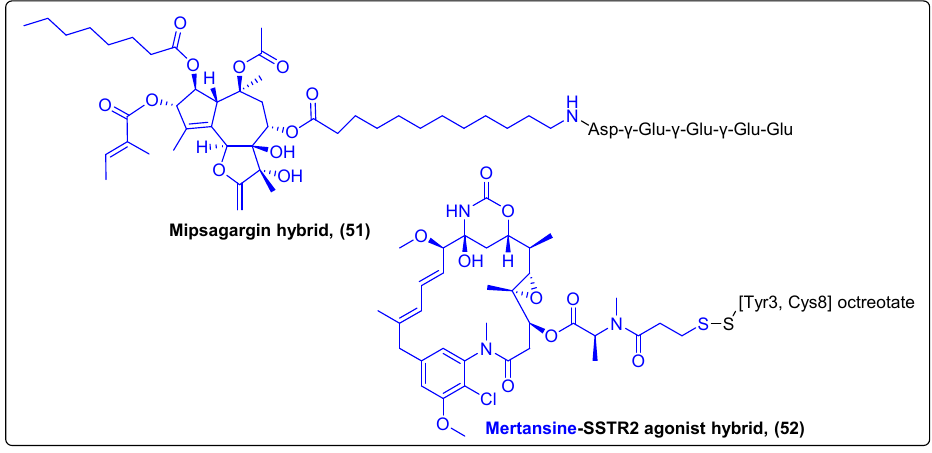
Figure 16. Mipsagargin and PEN-221 hybrids.